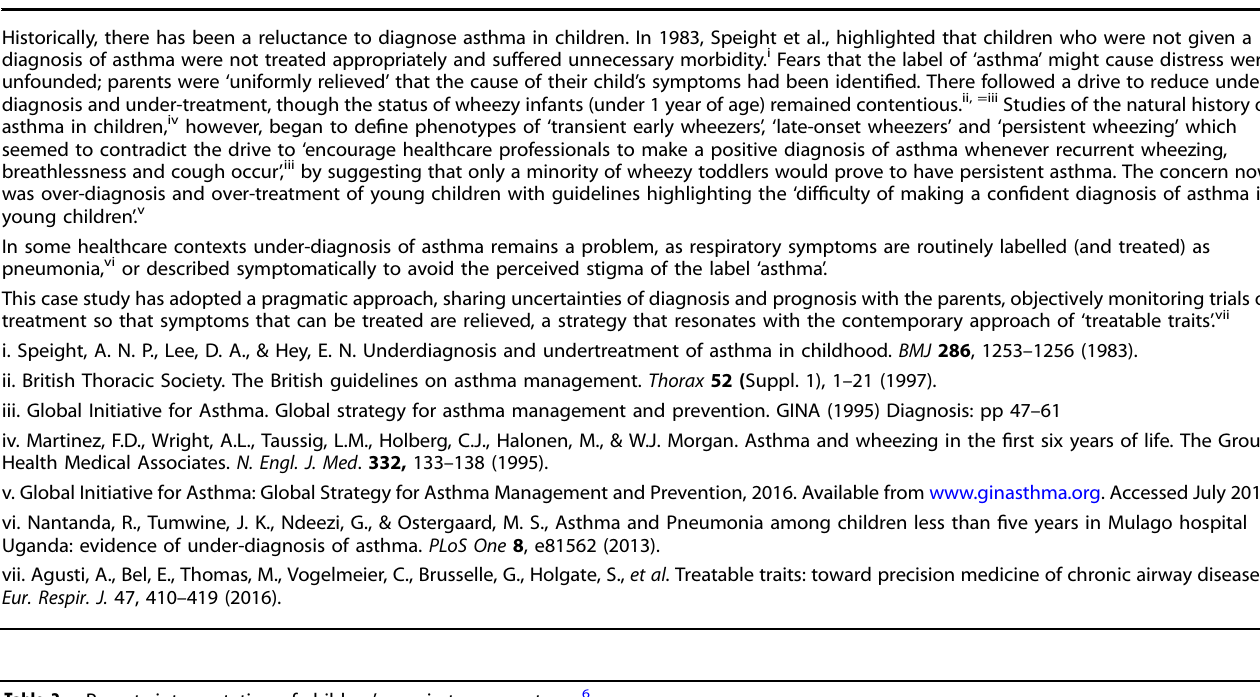
Table 1. Asthma: What ’ s in a name?